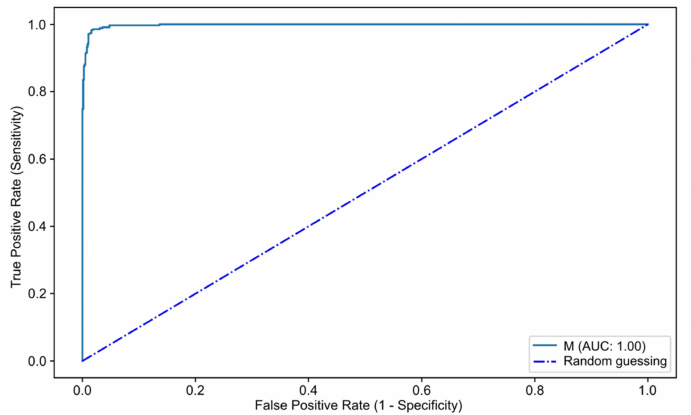
Figure 4. ROC analysis of the network’s performance in the detection of mucinous pancreatic cystic lesions. AUC—area under the receiver operating characteristic curve. M—mucinous pancreatic cystic